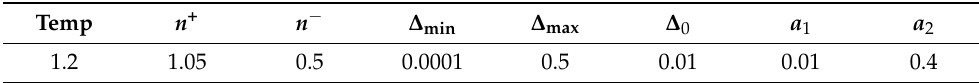
Table 2. Learning parameters of